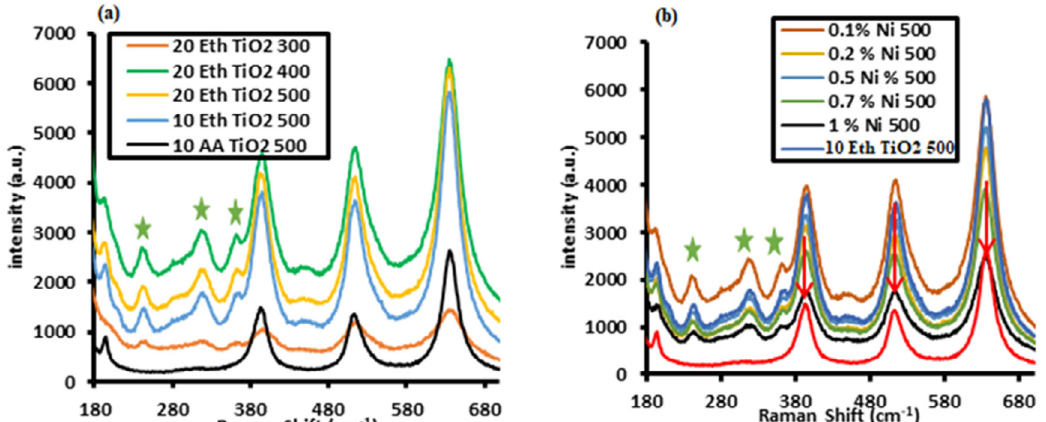
samples prepared in the presence of 10 mL ethanol and (b) Ni-TiO 2 of 10 mL ethanol heated at 500 °C (brookite